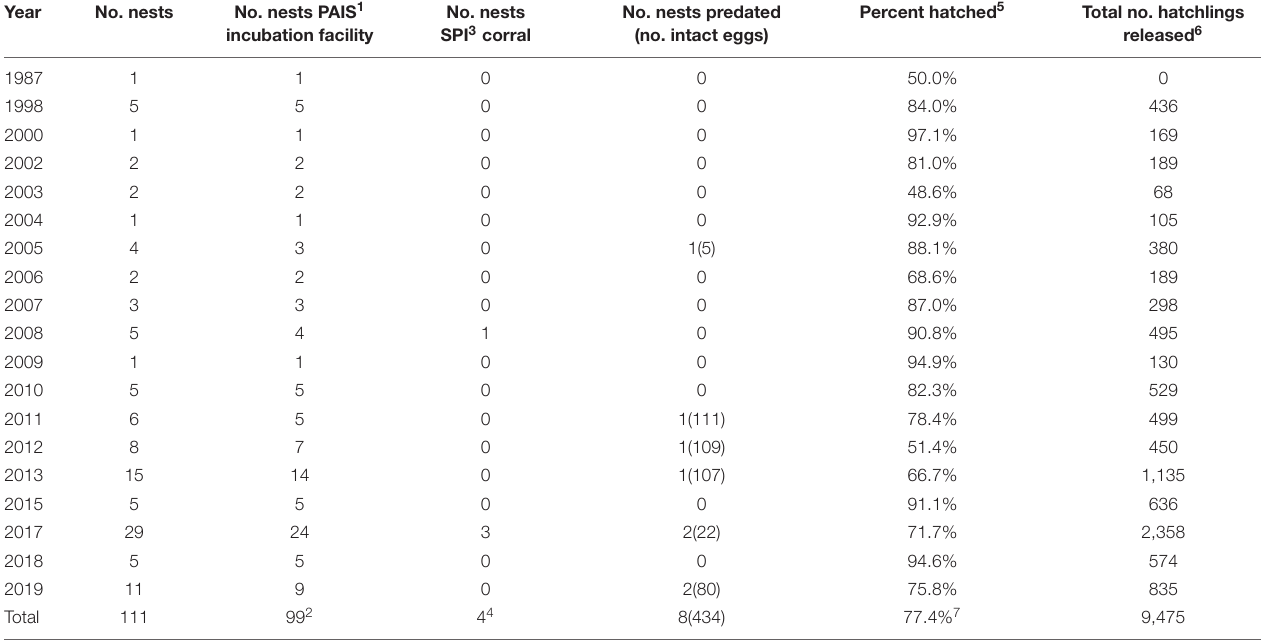
TABLE 1 | Summary of incubation, hatching, and release information for green turtle ( Chelonia mydas ) nests documented on the Texas coast from 1987 through 2019, including the annual number of nests found, number of nests by incubation method, number of nests predated, hatching success, and number of hatchlings released. Year No.